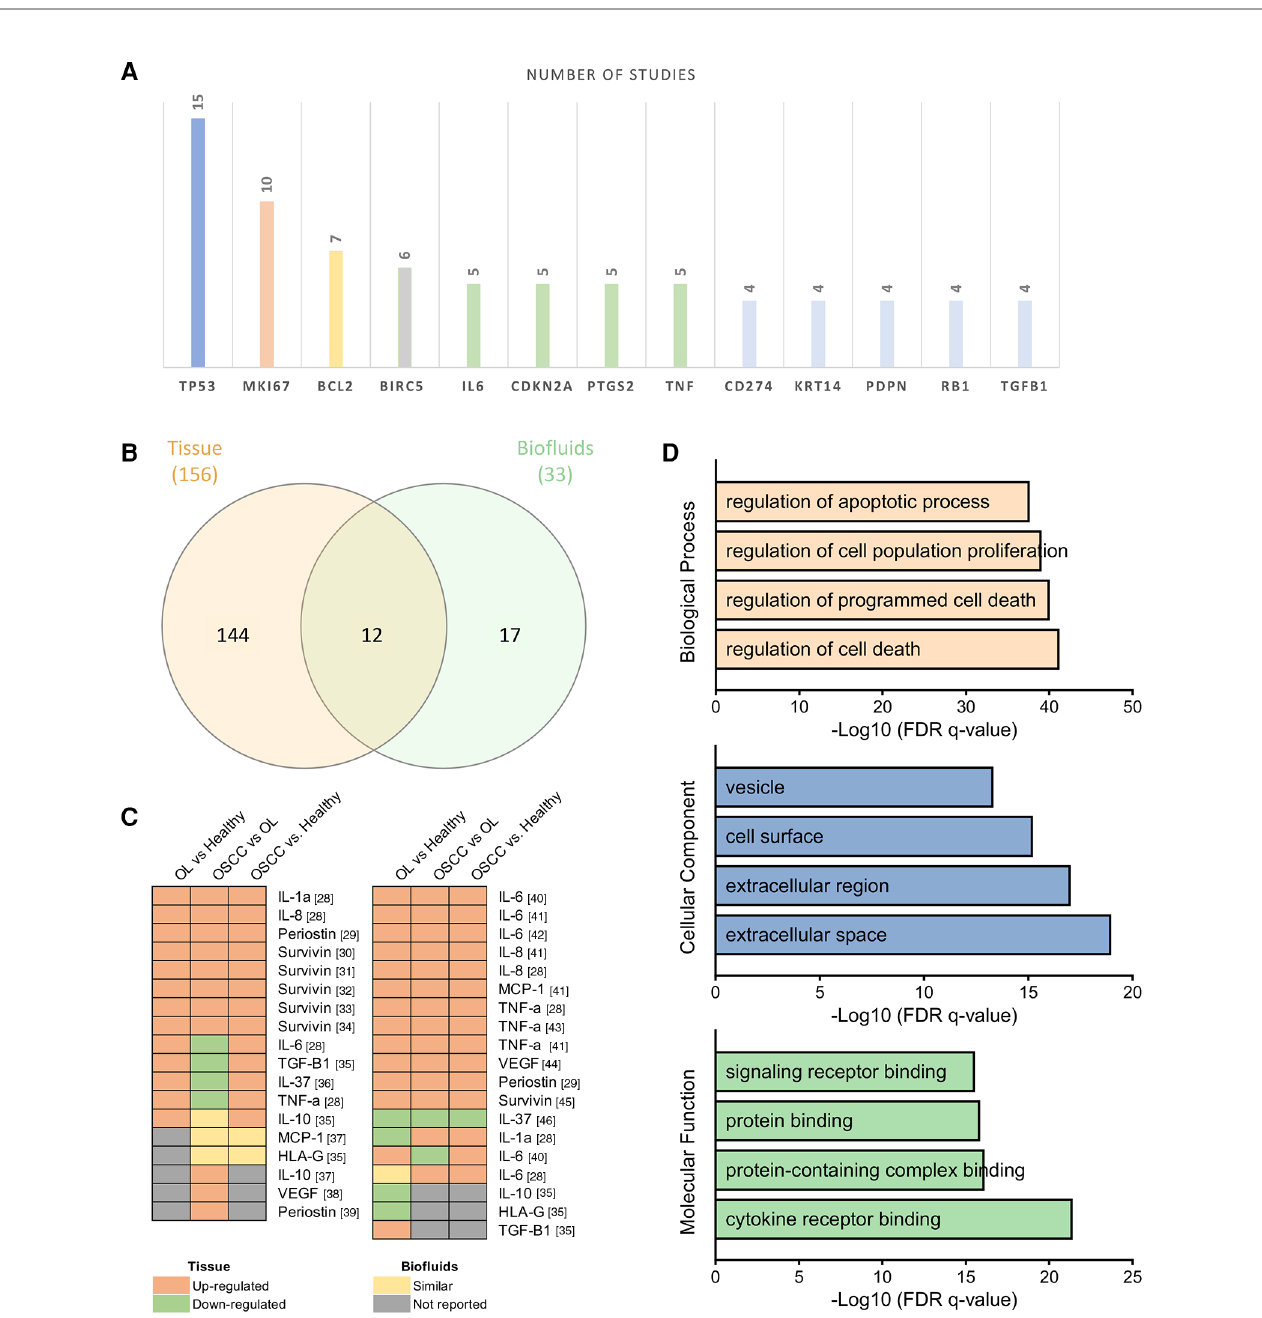
FIGURE 3 Analysis of assessed proteins among all included studies. ( A ) Top 13 genes evaluated in at least four distinct studies in descending order of frequency. ( B ) Venn diagram evidencing proteins exclusively assessed in tissue and bio fl uids samples, as well as in 12 shared proteins. ( C ) Heatmaps of the 12 shared proteins among tissues and bio fl uids representing the abundance pattern among the comparison pairs. In brackets the references. ( D ) Gene Ontology analysis performed by PANTHER highlights cell death regulation, cell proliferation, and apoptotic process among proteins mainly enriched in the extracellular